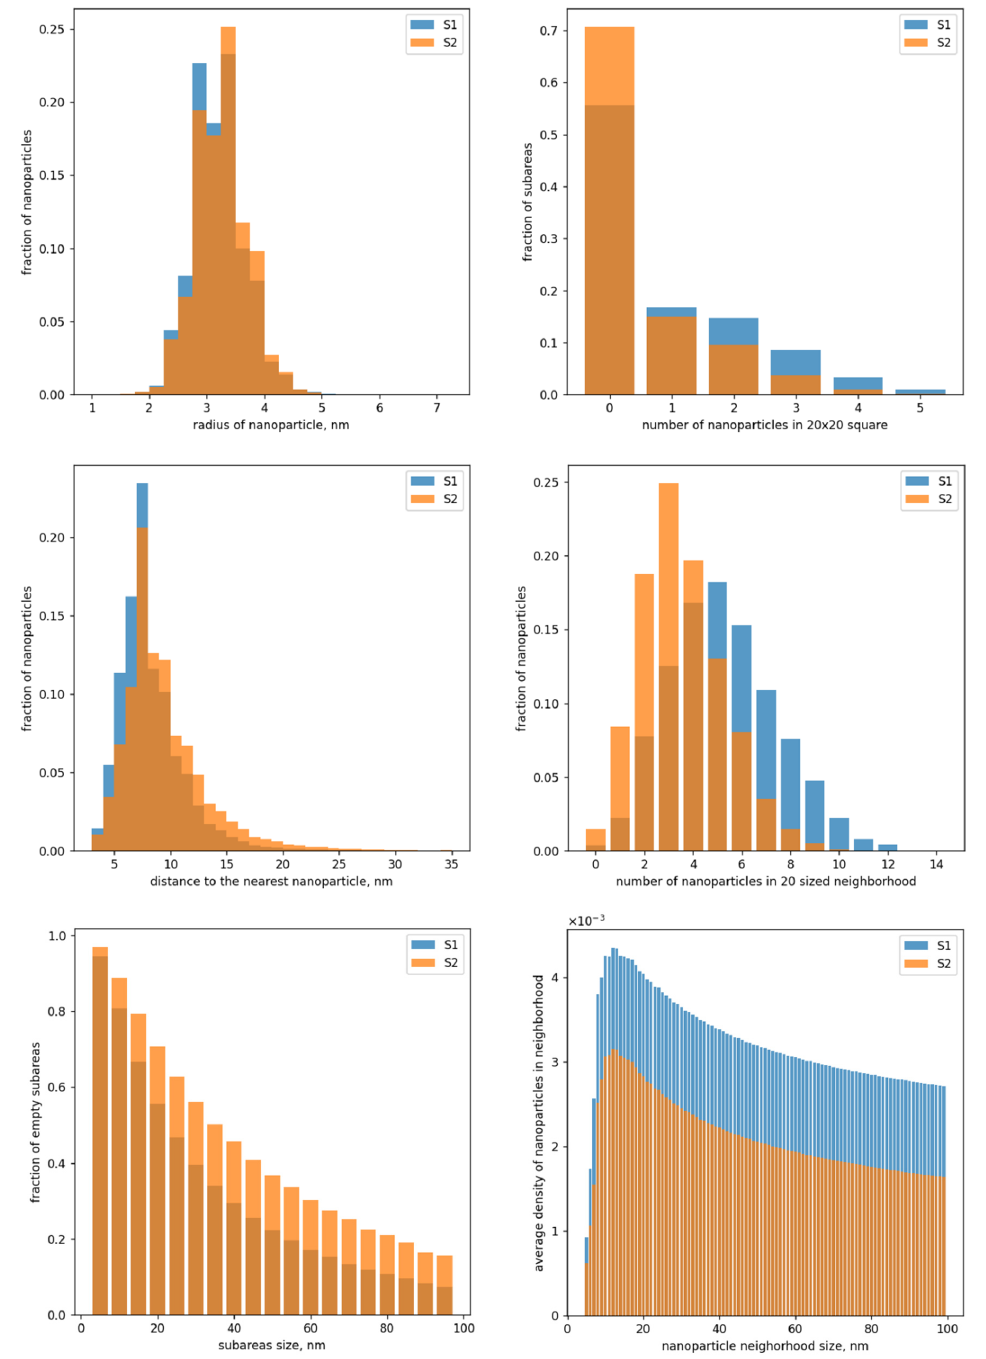
Figure 4. Charts averaged through all images of types S1 (blue) and S2 (orange).